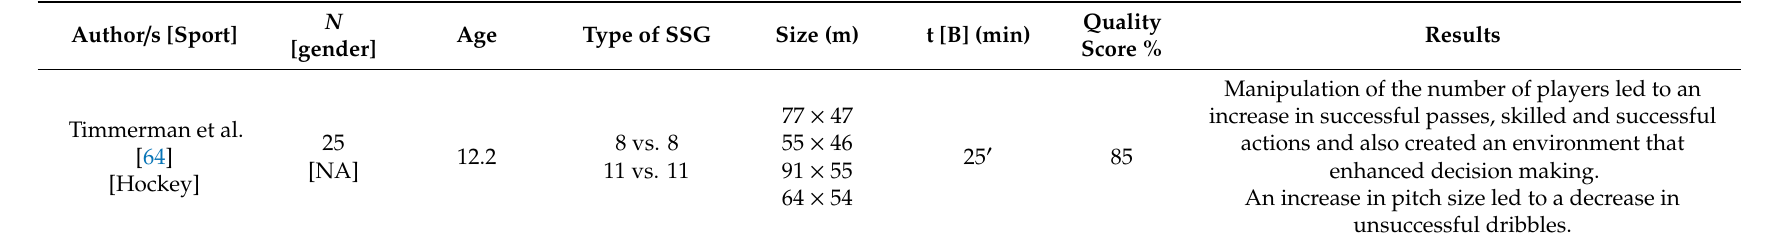
Table 3. E ff ects of SSGs on technical-tactical aspects in other